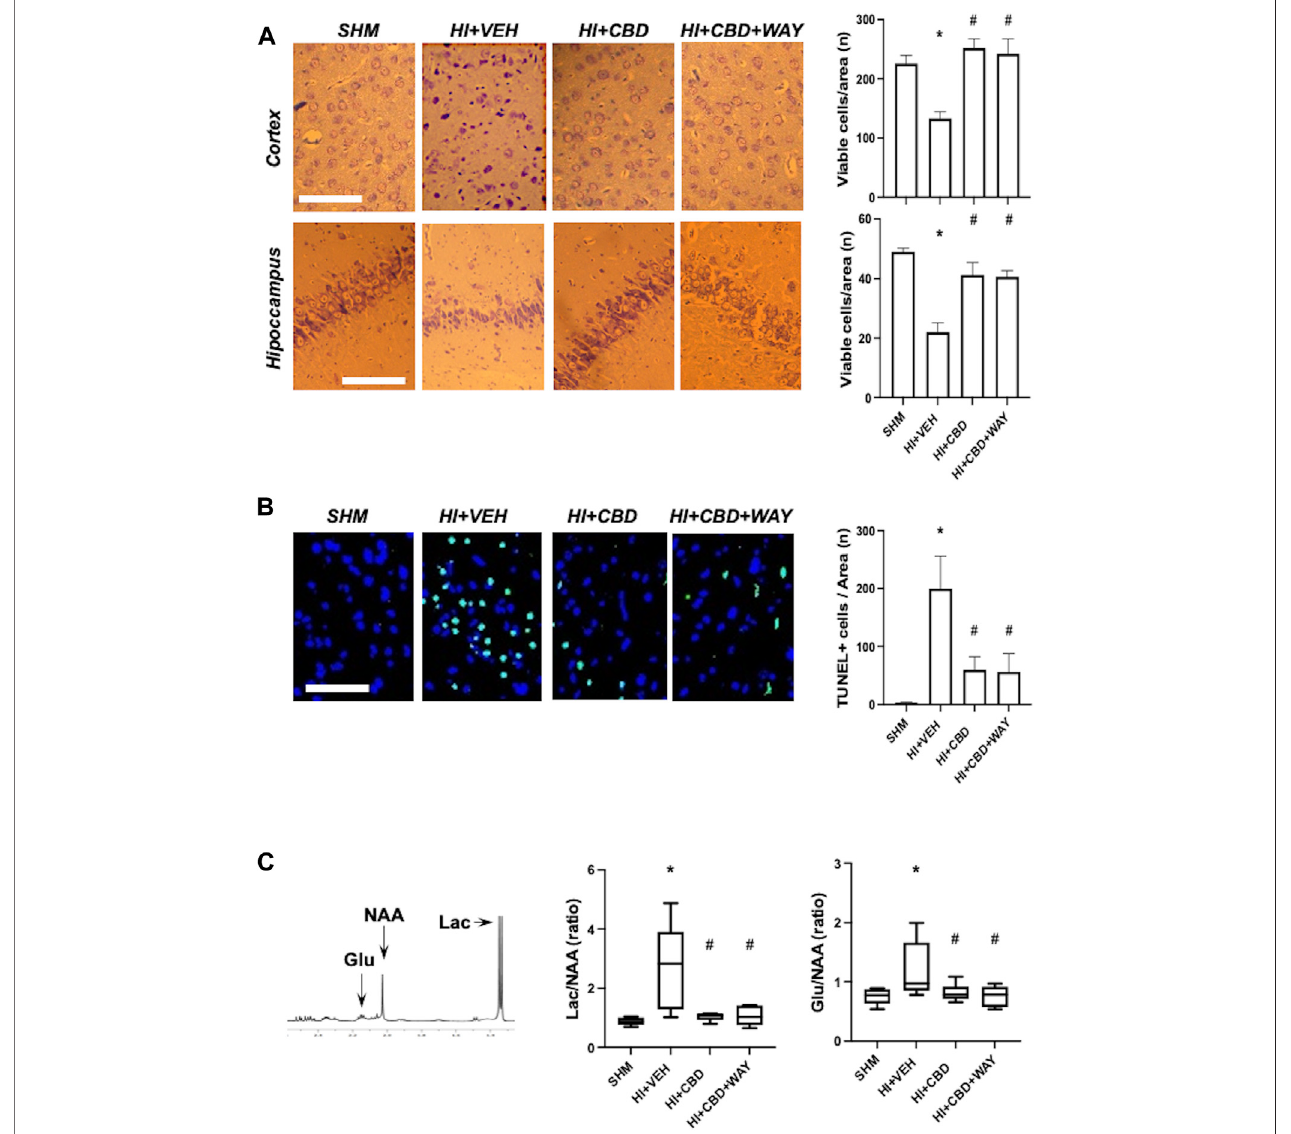
FIGURE 1 | Brain damage assessment 72 h after hypoxic – ischemic insult in brain samples from piglets treated with vehicle (HV), cannabidiol (HC), and WAY 100635 (HCW). Non-hypoxic – ischemic piglets served as controls (SHM). (A) Representative microphotographs ( left ) and quanti fi cation ( right ) of viable neurons